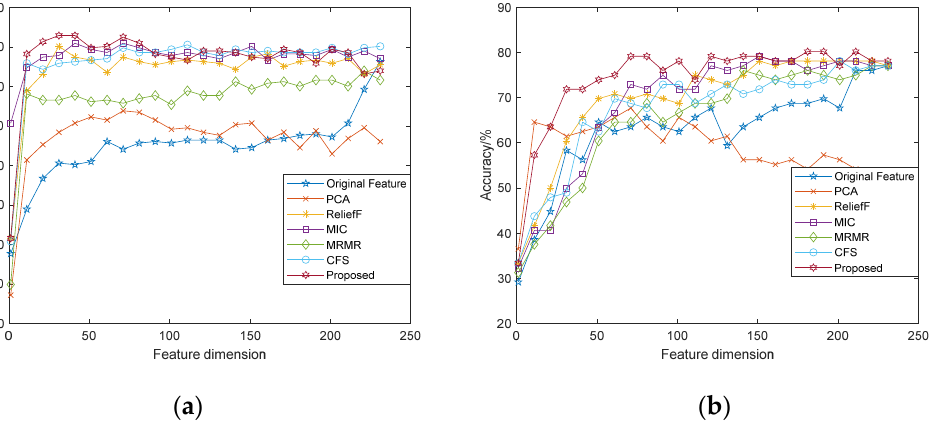
Figure 4. Accuracy comparison of feature subsets under different dimensions (SVM): ( a ) eNTERFACE’05 dataset; ( b ) SAVEE dataset.